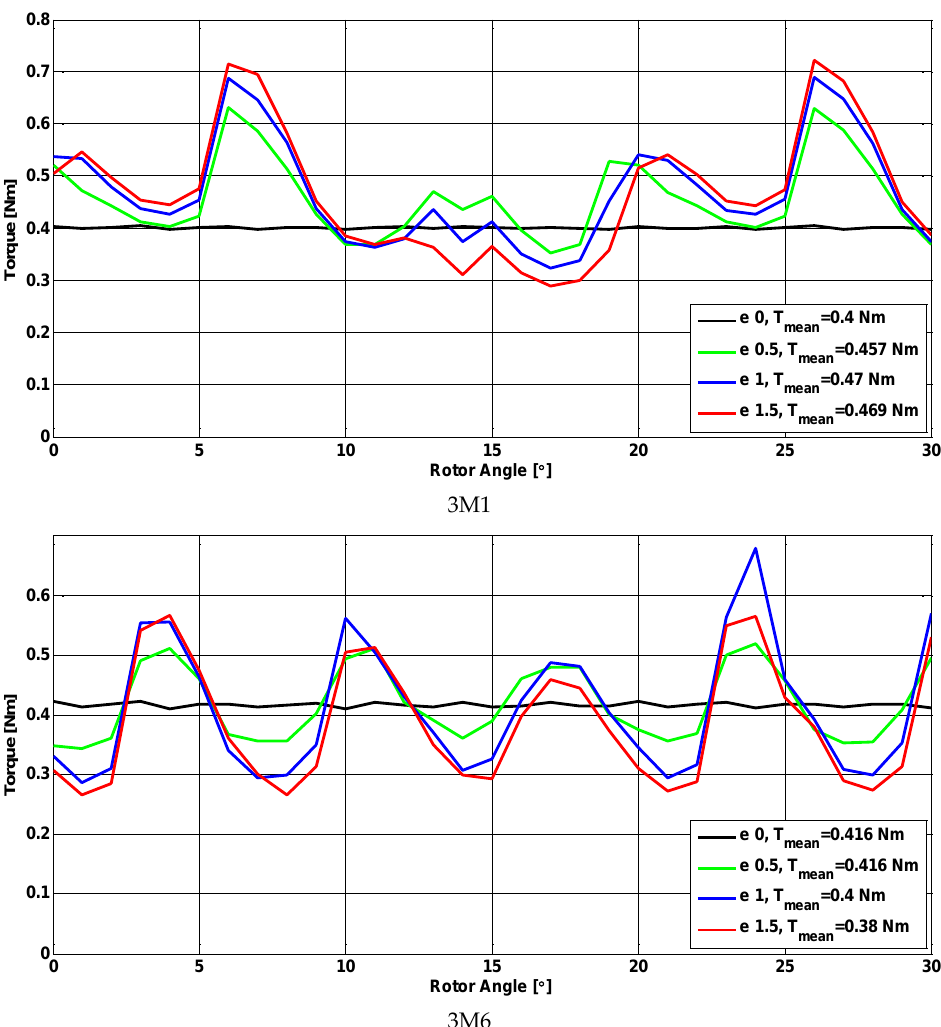
Figure 10. Torque vs. position for all the considered ZAIMs.